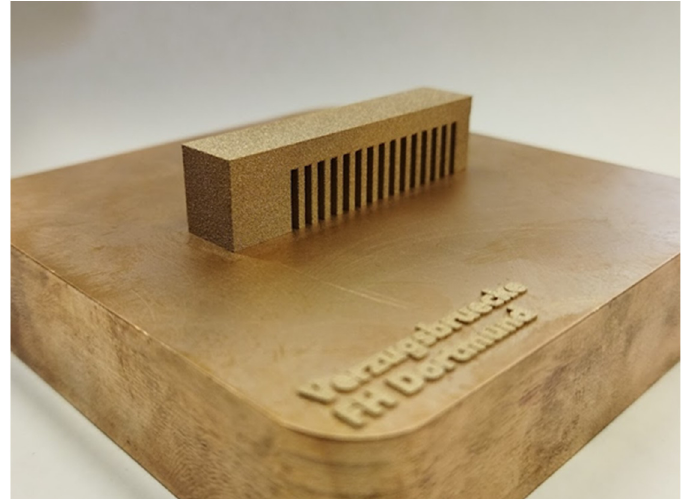
Figure 4. Side view of the distortion bridge with drawn-in measuring ranges for the residual stress.